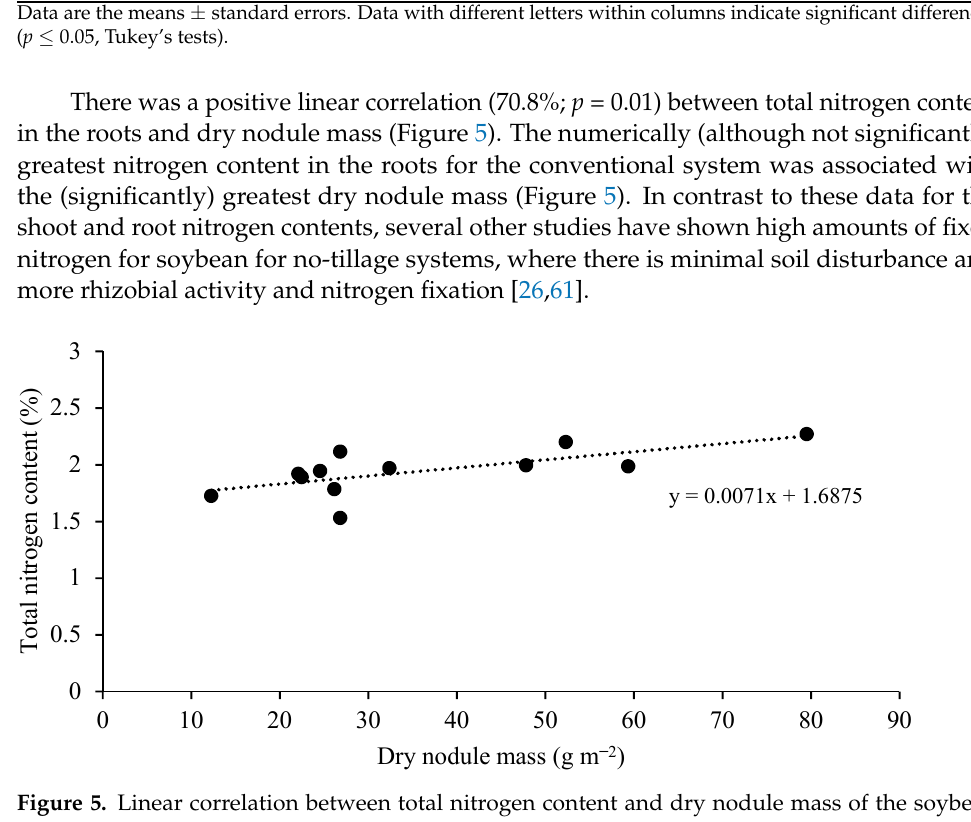
Figure 6. Soybean shoot and root C/N ratios according to the different tillage systems (CN, conventional; CS, conservation; NT, no-tillage). Data are the means ± standard error. Letters (a) indicate nonsignificant differences ( p ≤ 0.05, Tukey’s tests) among treatments.